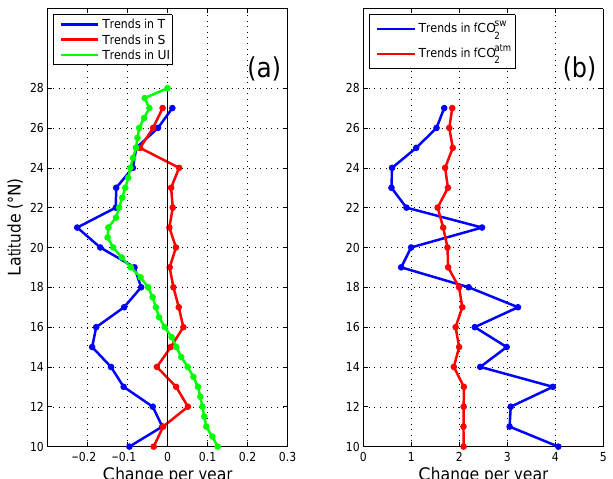
Figure 4. Latitudinal distribution of the interannual trends for the upwelling index (UI) and for the four experimental variables along the QUIMA-VOS line integrated over every degree between 2005 and 2012. Panel (a) presents the trends for upwelling index (UI, × 10 − 3 m 2 s − 1 , mean confidence interval of 9m 2 s − 1 ) , SST ( ◦ Cyr − 1 , confidence interval 0.13 ◦ C), and SSS (yr − 1 , confidence interval 0.06) and (b) the trends for f CO sw dence intervals 4.23 and